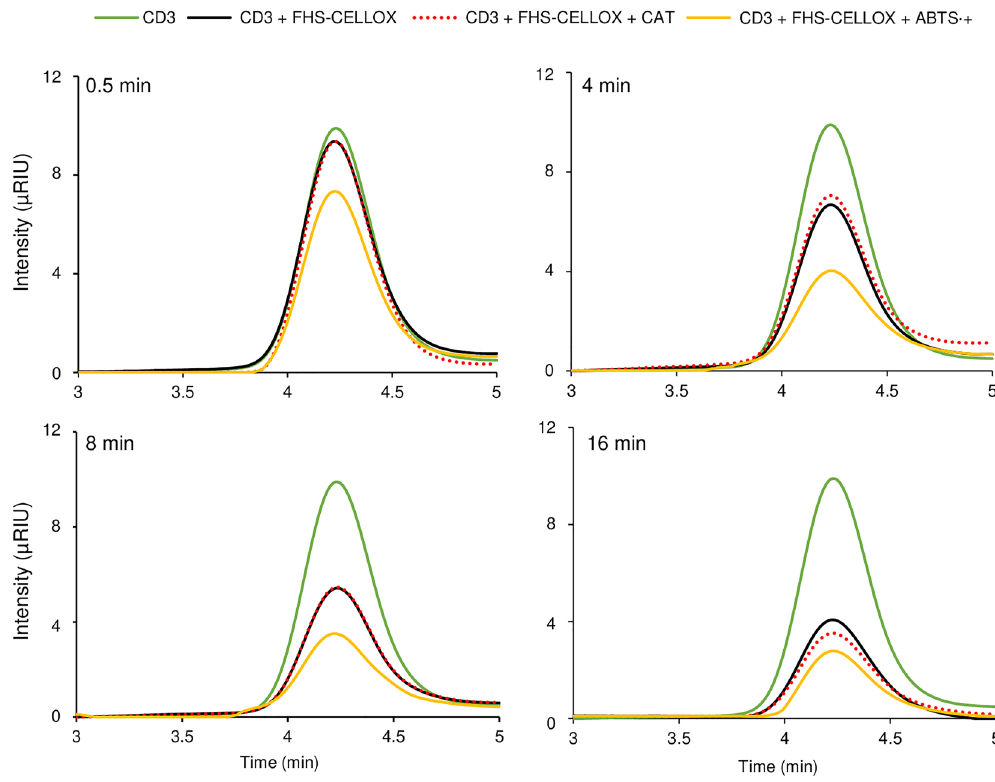
Figure 5. Analysis of residual CD3 upon incubation with FHS-CELLOX and ABTS ·+ . Chromatographic analysis of CD3 alone (CD3) (12 µg), CD3 incubated with FHS-CELLOX (CD3 + FHS-CELLOX), CD3 incubated with FHS-CELLOX and catalase (CD3 + FHS-CELLOX + CAT) and CD3 incubated with FHS- CELLOX and ABTS ·+ /ABTS (CD3 + FHS-CELLOX + ABTS ·+ ). Analysis was performed after 0.5, 4, 8 and 16 min of reaction. CD3 and FHS-CELLOX were used at 600 µM and 0.7 µM, respectively. ABTS ·+ /ABTS pair was used at 1 mM (800/200 µM). [ ABTS 2,2’-azino-bis (3-ethylbenzothiazoline-6-sulfonic acid), CAT catalase from bovine liver, CD3 cellotriose, FHS-CELLOX flag-his-sumoylated